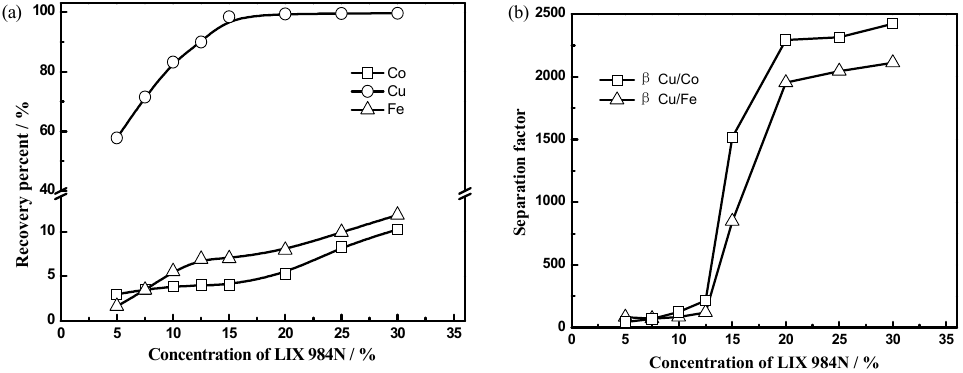
Figure 4. Effect of concentration of LIX 984N on the recoveries of copper, cobalt, and iron ( a ) and separation factor ( b ) (A/O phase ratio = 1/1, pH = 1.25, contact time = 20 min, temperature = 25 °C).